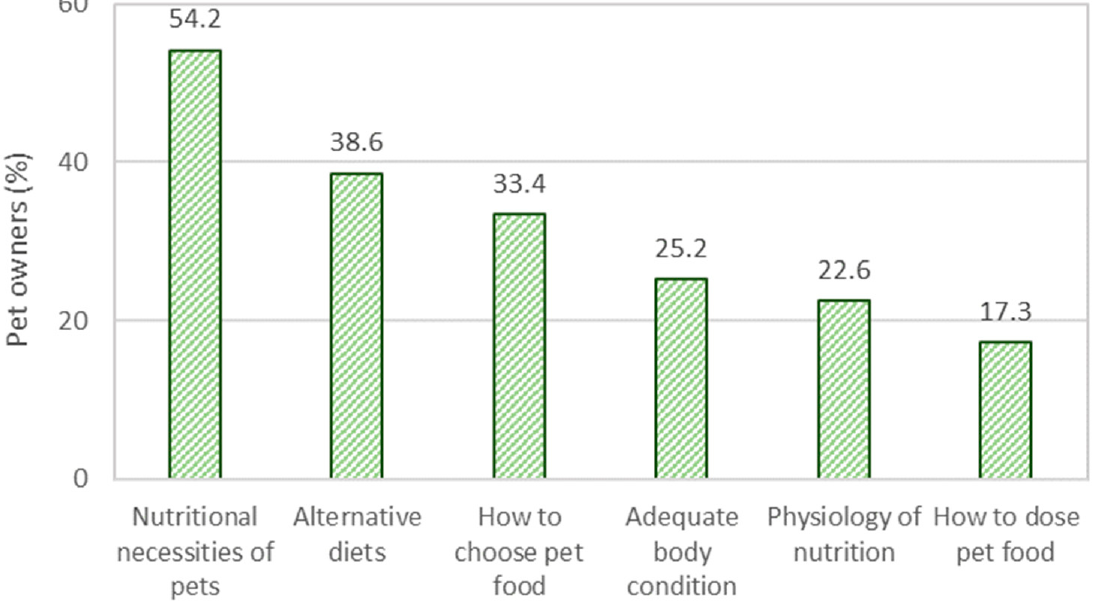
Figure 5 . Self-reported information needs on pet feed and nutrition of Portuguese pet owners.